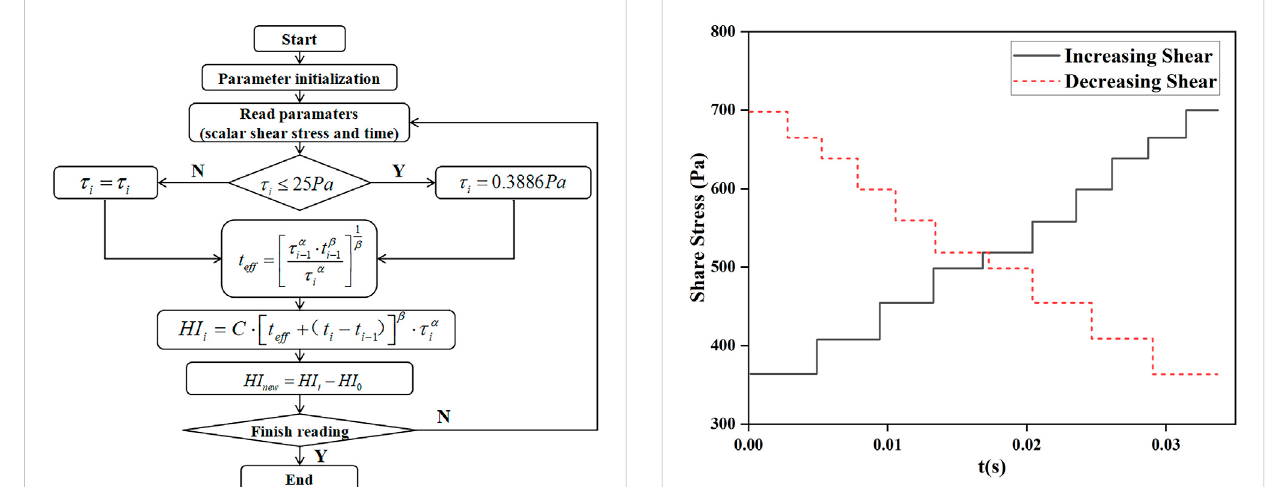
FIGURE 3 Variation inloadedshear stresswith time studied byYeleswarapu et al.